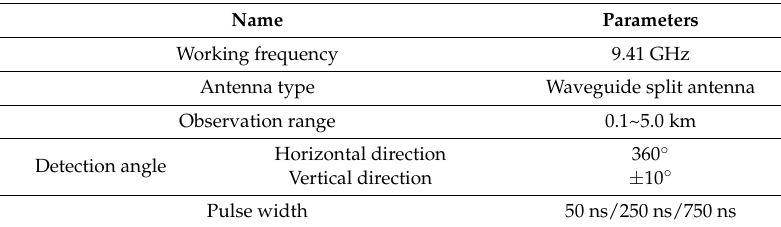
Table 1. Main parameters of X-band marine radar.